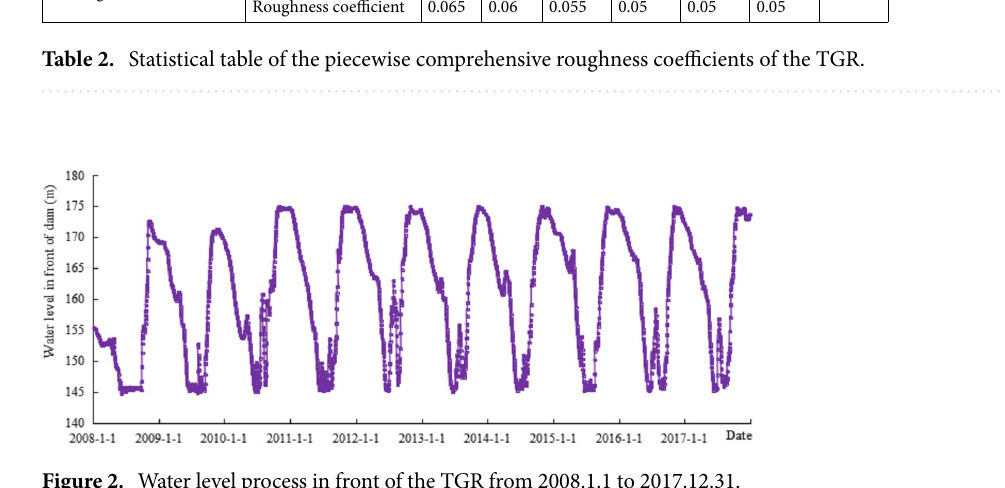
Figure 2. Water level process in front of the TGR from 2008.1.1 to